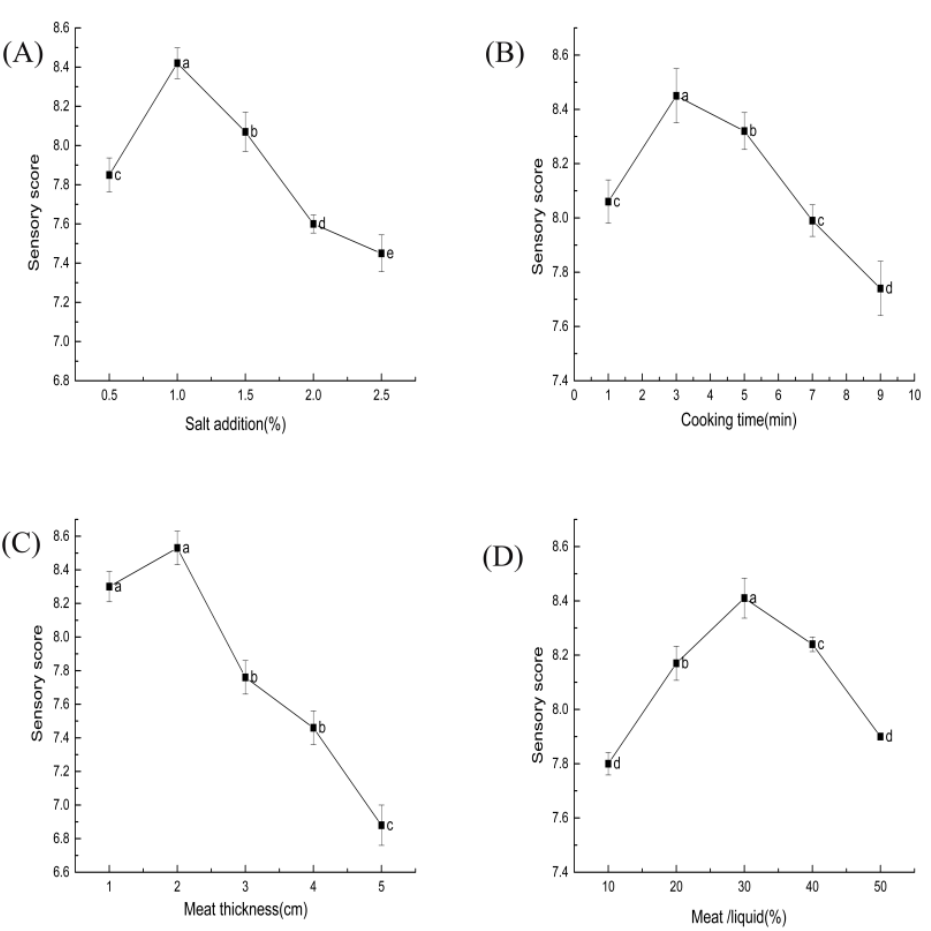
Figure 3. Effect of each factor on the sensory of ST beef: ( A ) salt addition (based on ST mass); ( B ) cooking time; ( C ) meat thickness; ( D ) beef–ST ratio. Different letters above each bar mean significant differences.